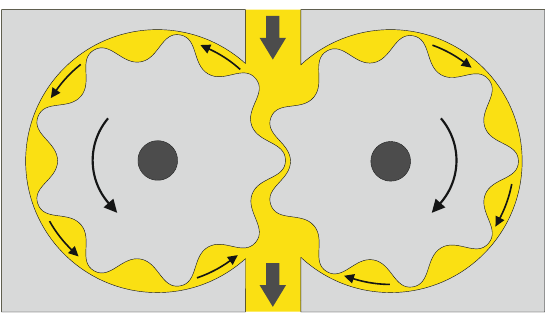
Figure 2. Working principle of a melt (gear) pump. By way of illustration, the polymer melt is represented in yellow.